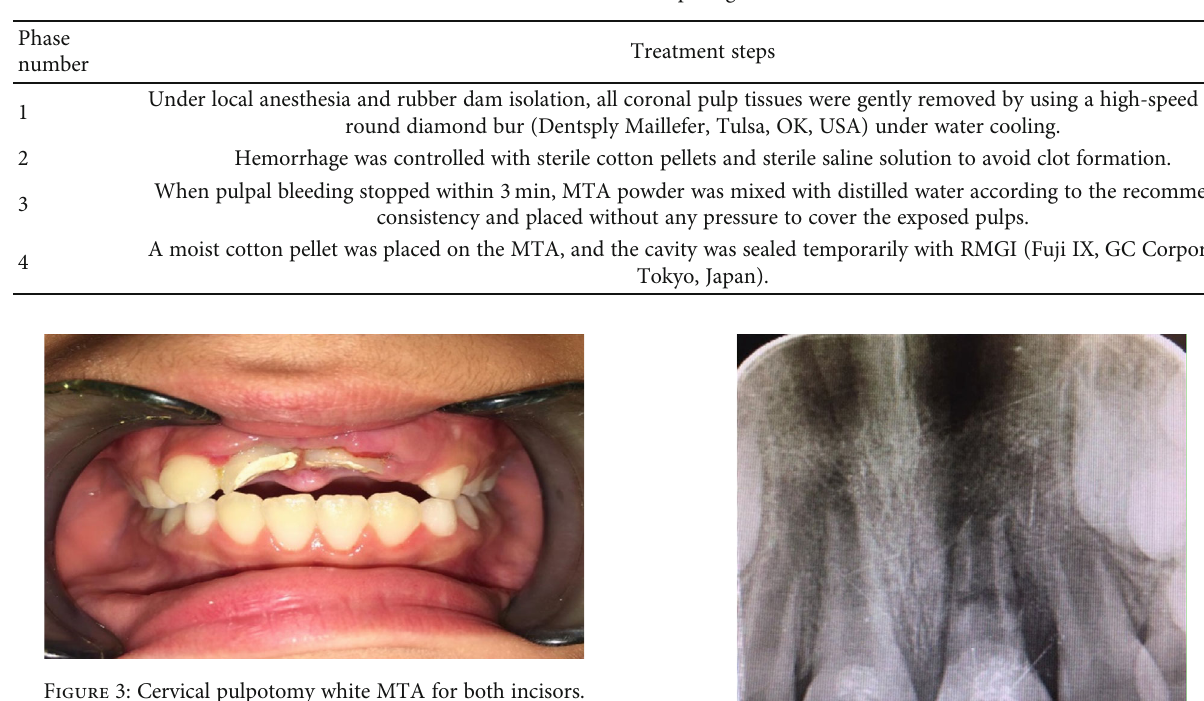
Table 2: Clinical passages.